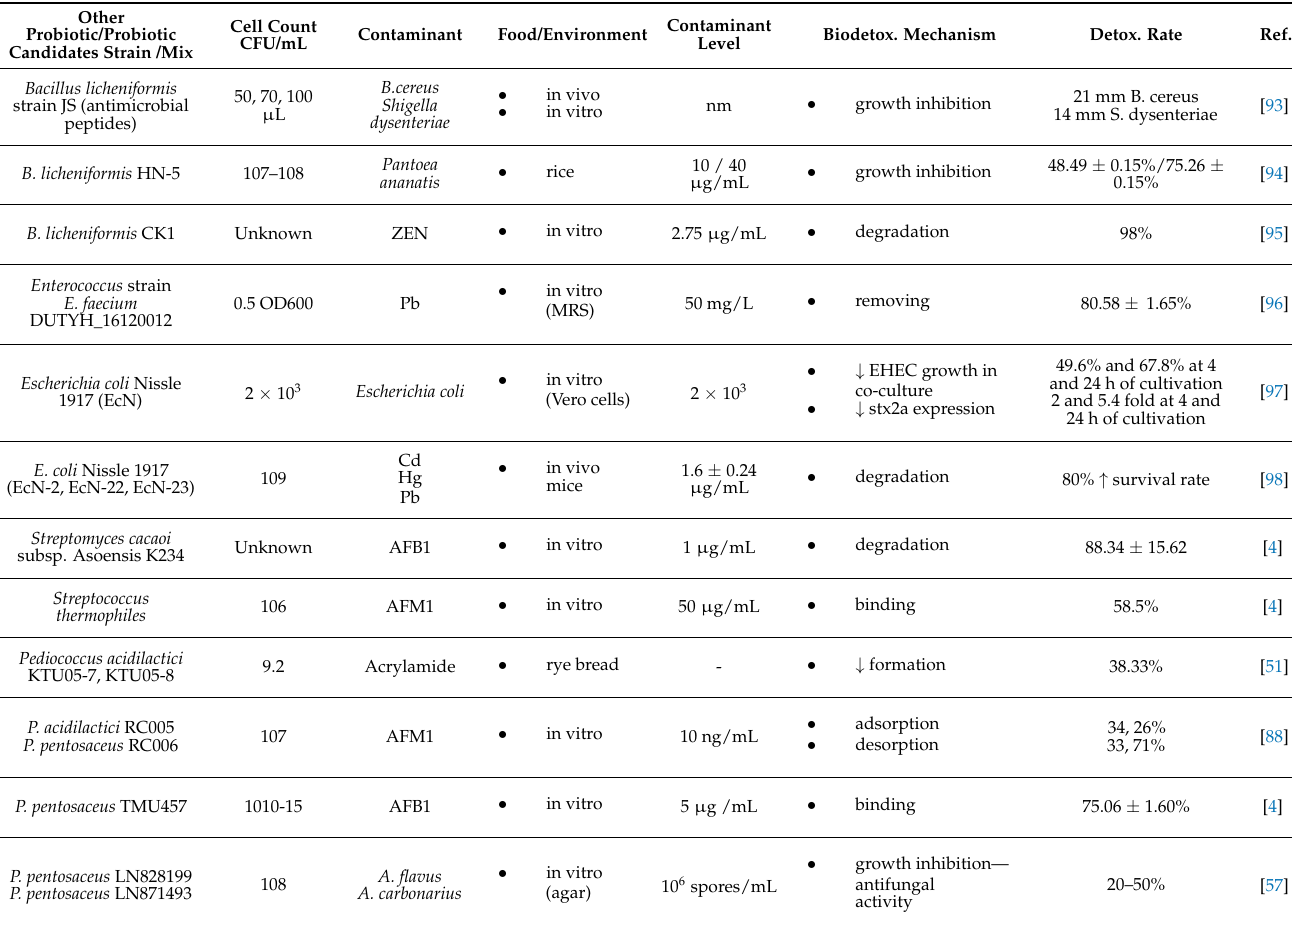
Table 4. Other probiotic strains or promising probiotic candidates, their biodetoxification mechanisms, and rates for different food